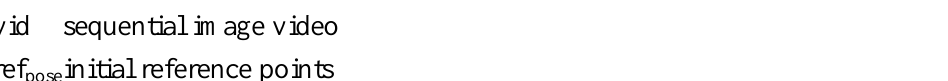
Algorithm 1 Monocular SLAM with DI-D feature initialization (vid, refpose).